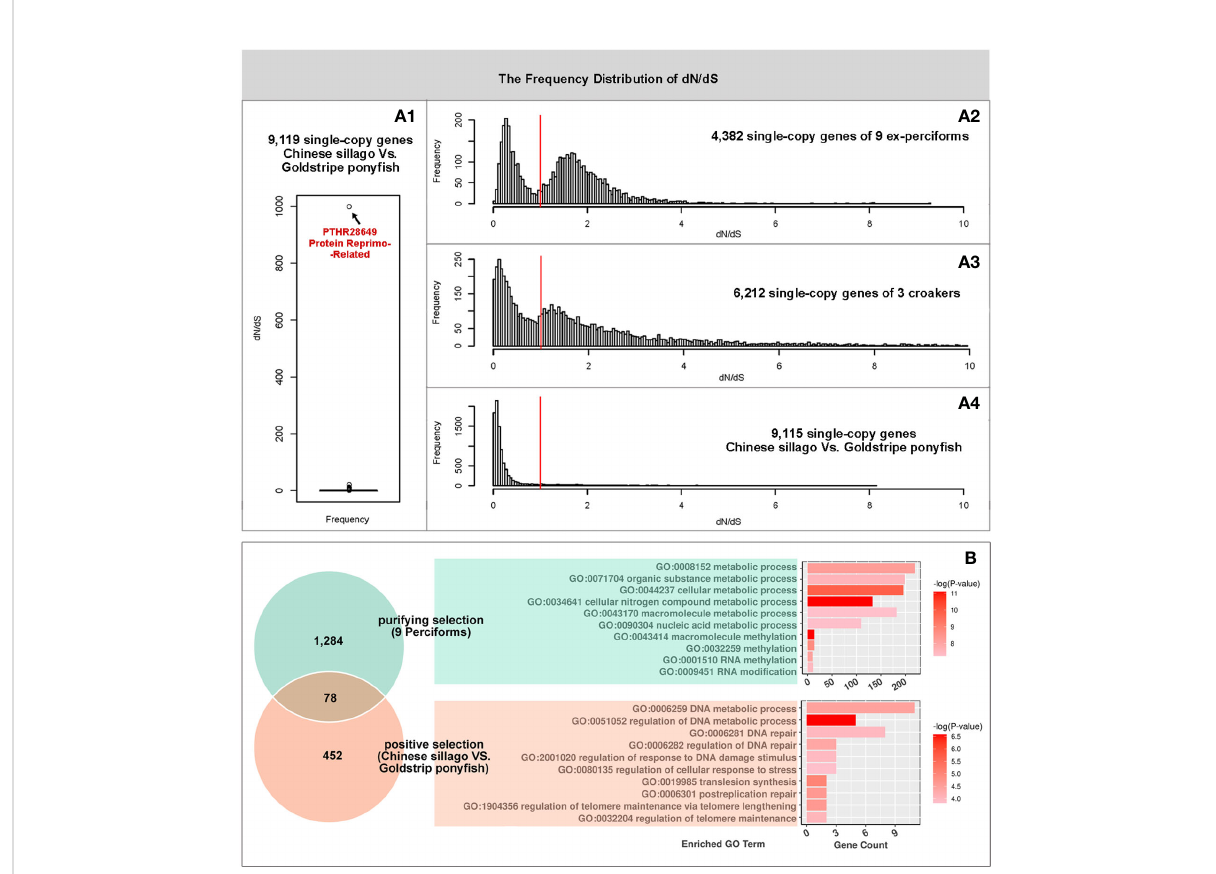
FIGURE 2 The analysis of positive selected genes. A1 Boxplot of dN/dS values in goldstripe pony fi sh and Chinese sillago single-copy genes. A2-A4. The frequency distribution of dN/dS in nine ex-perciforms, three croakers, and goldstripe pony fi sh vs . Chinese sillago. (B) The venn diagram depicts the purifying selected genes in the nine ex-perciforms as well as the positive selected genes in the goldstripe pony fi sh and Chinese sillago. The bars depict the enrichment analysis of both gene groups. The fact that the Venn diagram and bar plot have the same background colors indicates that the same gene set was